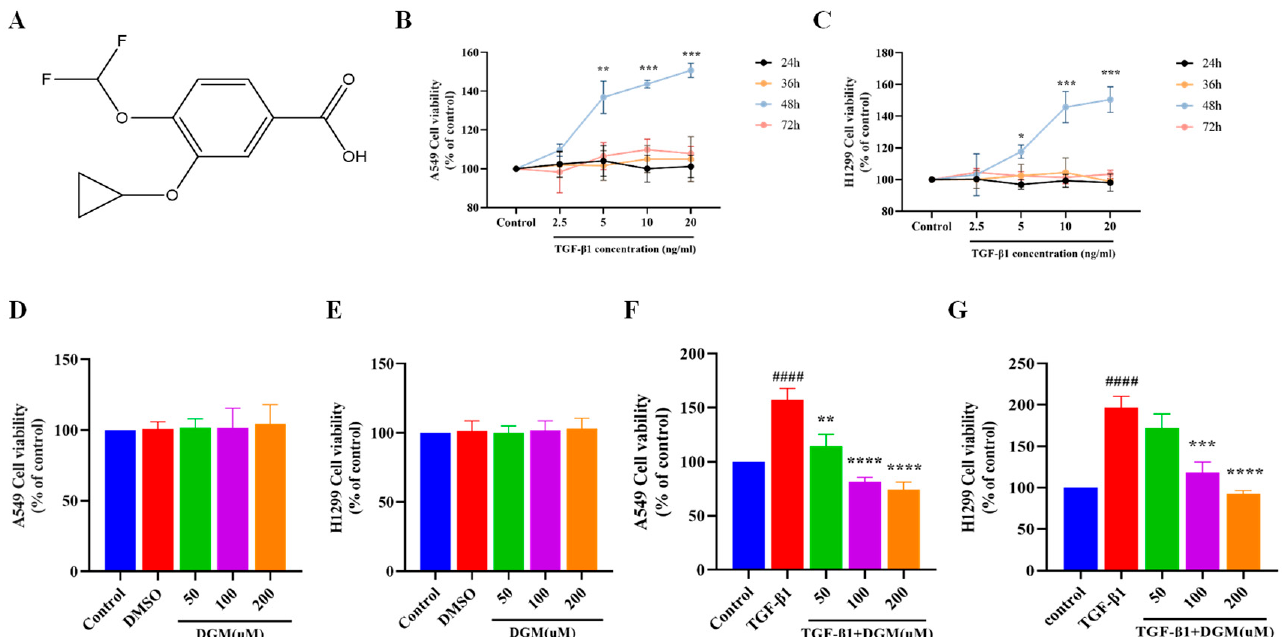
Figure 1. Effects of DGM on TGF- β 1 induced proliferation of A549 and H1299 cells. Cells were treated with TGF- β 1 and different concentrations (50, 100, and 200 μ M) of DGM for 48 h. ( A ) Chem- ical structure of DGM. ( B ) A549 cell viability was evaluated using the MTT assay after stimulation of TGF- β 1 at different concentrations for 24 h, 36 h, 48 h, and 72 h. ( C ) H12999 cell viability was evaluated by the MTT assay after stimulation of TGF- β 1 at different concentrations for 24 h, 36 h, 48 h, and 72 h. ( D ) The cell viability of A549 cells and ( E ) H1299 cells treated with DGM (50, 100, 200 μ M) for 24 h was determined by MTT assay. ( F ) A549 cells and ( G ) H1299 cells were treated with TGF- β 1 and different concentrations of DGM (50, 100, and 200 μ M) for 48 h. Values are presented as mean ± SEM ( n = 6). * p < 0.05, ** p < 0.01, *** p < 0.001, **** p < 0.0001 vs. control group. #### p < 0.0001 vs. Control group; * p < 0.05, ** p < 0.01, *** p < 0.001, *** p < 0.0001 vs. TGF- β 1 group.